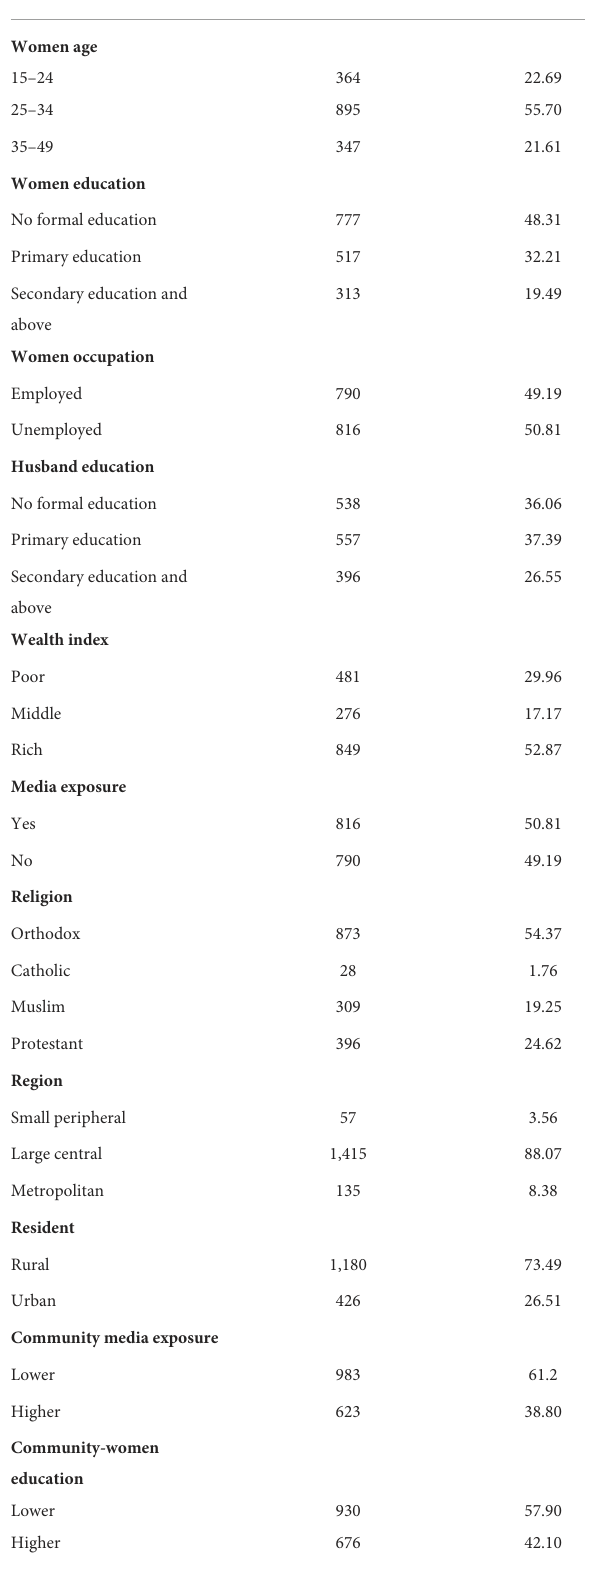
TABLE 1 Individual and community level factors associated with poor adherence to IFAS in